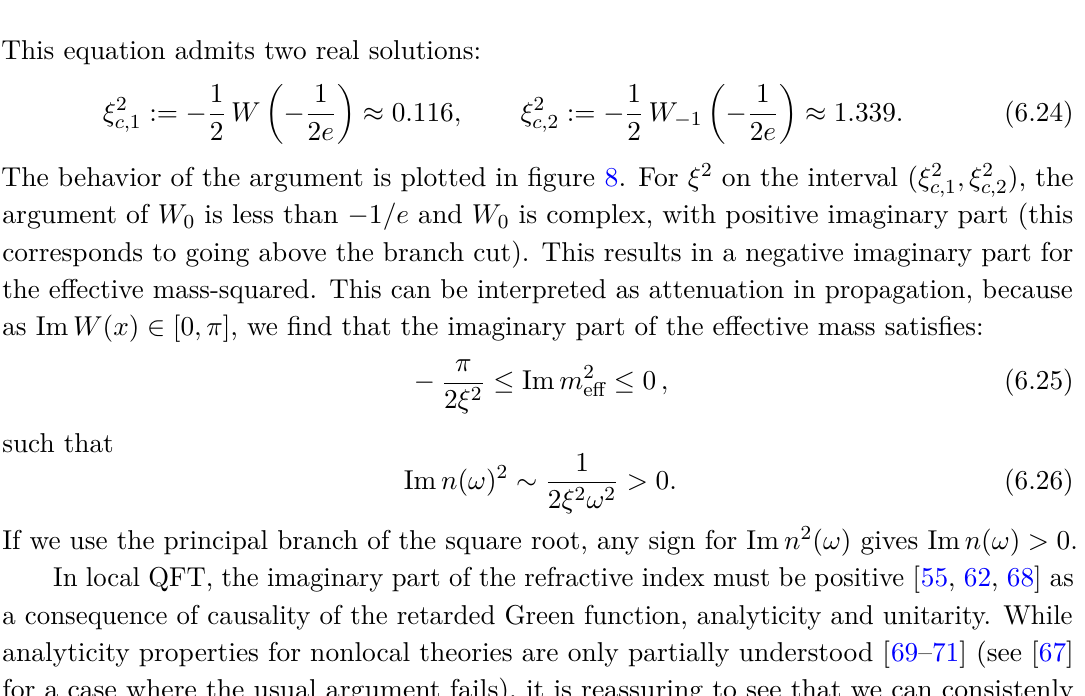
Figure 7 . Phase and group velocities for a scalar with m 2 > 0 as a function of ω . The continuous lines correspond to the case ξ 2 = 0 . 1 (nonlocal). The dashed lines correspond to ξ = 0